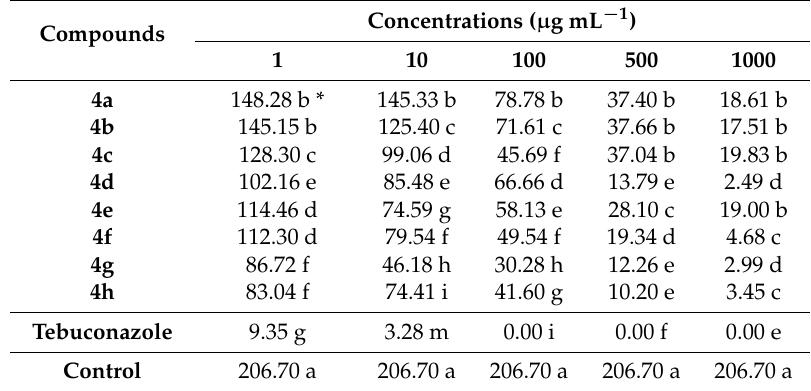
Table 2. Mean values for spores mL − 1 of Colletotrichum gloeosporioides treated with Triazoles 4a – 4h .